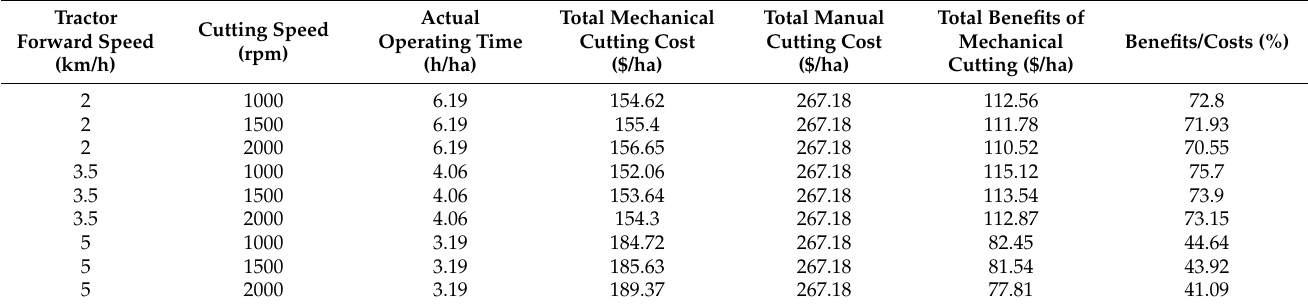
Table 3. Cost-benefit ratio for different forward speeds and cutting